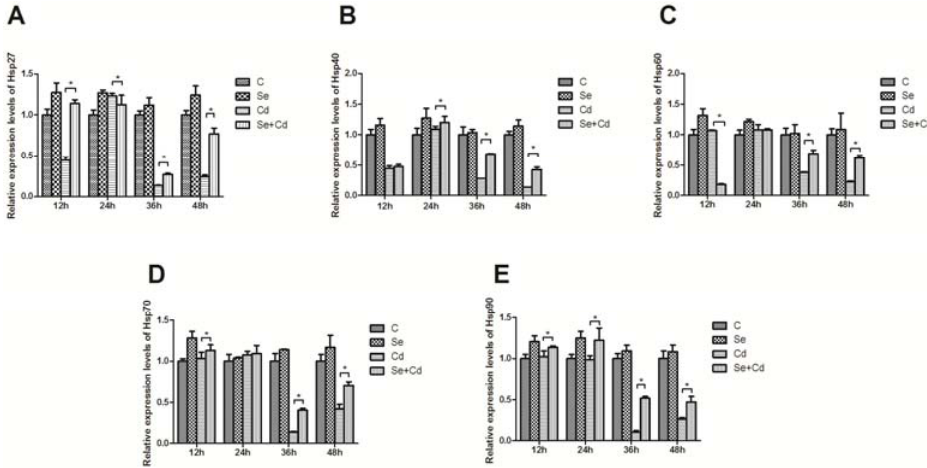
Figure 1. Effects of Se on Cd-induced changes in the mRNA levels of HSP. Panels A – E represent the effects of Se on Cd-induced changes in the mRNA levels of HSP27, HSP40, HSP60, HSP70, HSP90, respectively. The relative mRNA levels from the C groups were used as the reference values, the * with connecting lines indicated that there were significant differences ( p < 0.05) between any two groups. Each value represented the mean ± SD of 5